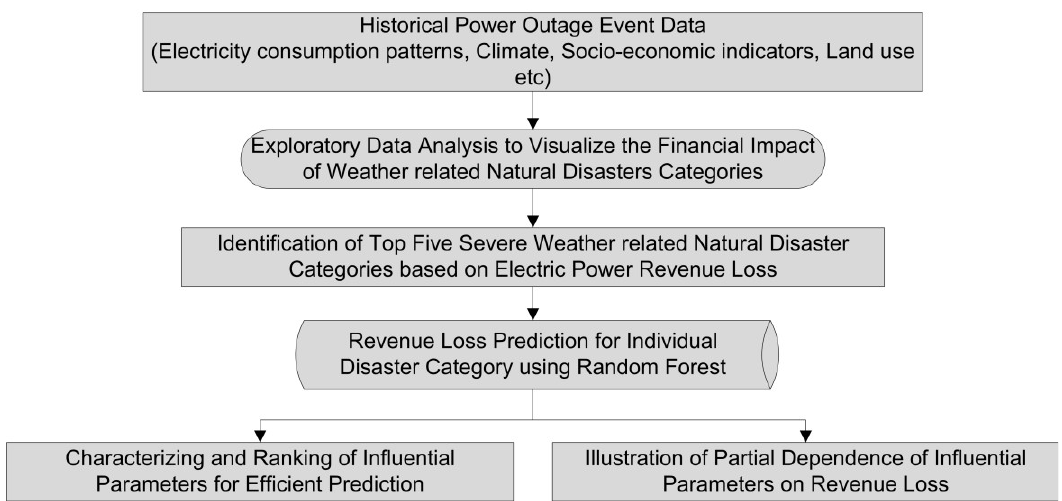
Figure 8. Flow chart of overall research methodology.